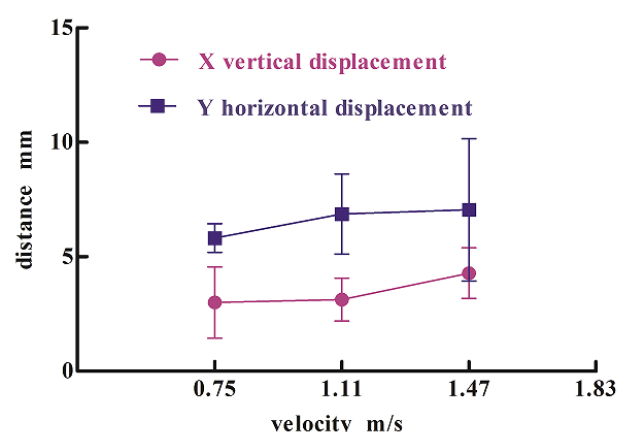
Figure 6. Heap soil phenomenon after soil covering with various open angles of the discs. ( a ) heap soil phenomenon after soil covering with 50 degree of the discs; ( b ) heap soil phenomenon after soil covering with 60 degree of the discs; ( c ) heap soil phenomenon after soil covering with 70 degree of the discs.